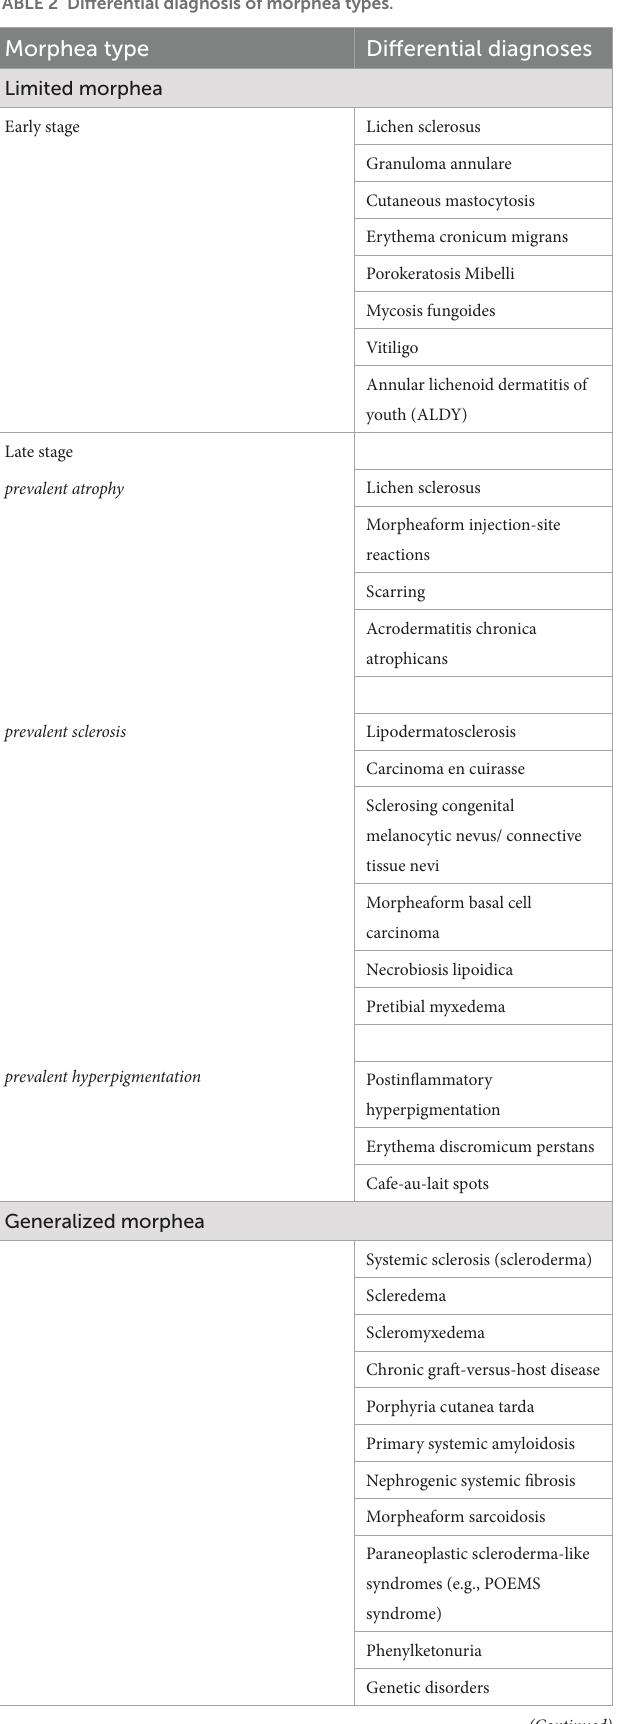
TABLE 2 Differential diagnosis of morphea